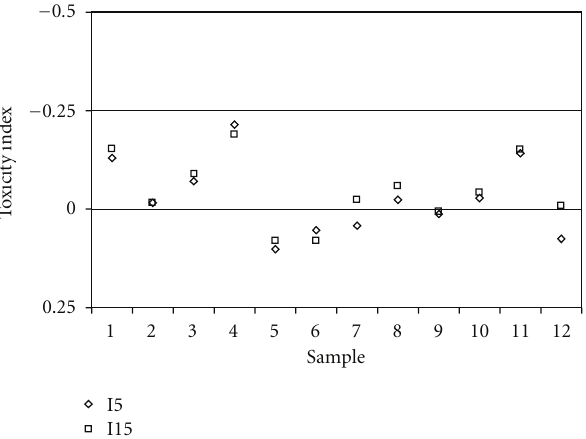
Figure 3: Toxicity index of the water extract in the sediment